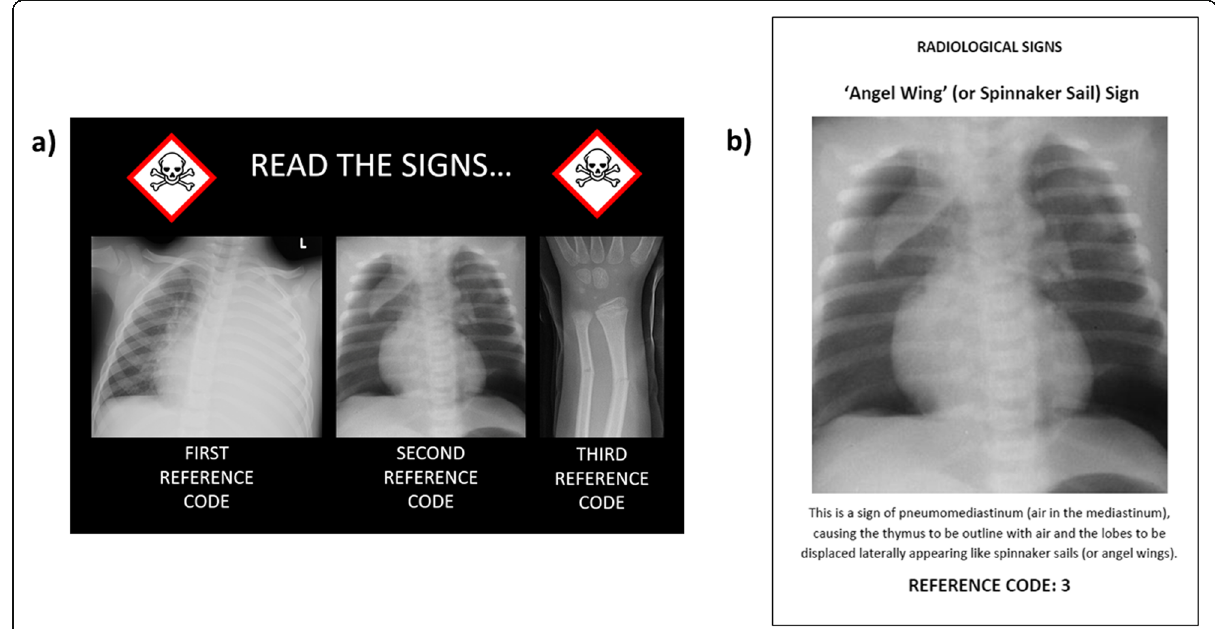
Fig. 1 ‘ Read the signs ’ : an example of one of the puzzles in the escape room. a A poster detailing three different paediatric radiographs with abnormalities is placed on one of the walls of the room. The students need to find a hidden folder of ‘ radiology signs ’ somewhere in the room containing 20 different imaging signs and match the images on the poster to that in the folder to solve the three number combination code. b An example of one of the pages in the clear plastic presentation folder matching the second image on the poster. In this example, the second number for the combination code would be ‘ 3